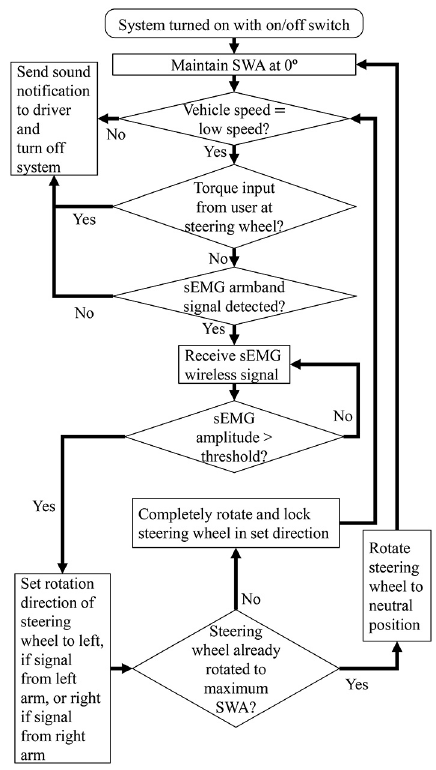
Figure 2 Operation scheme of steering assistance